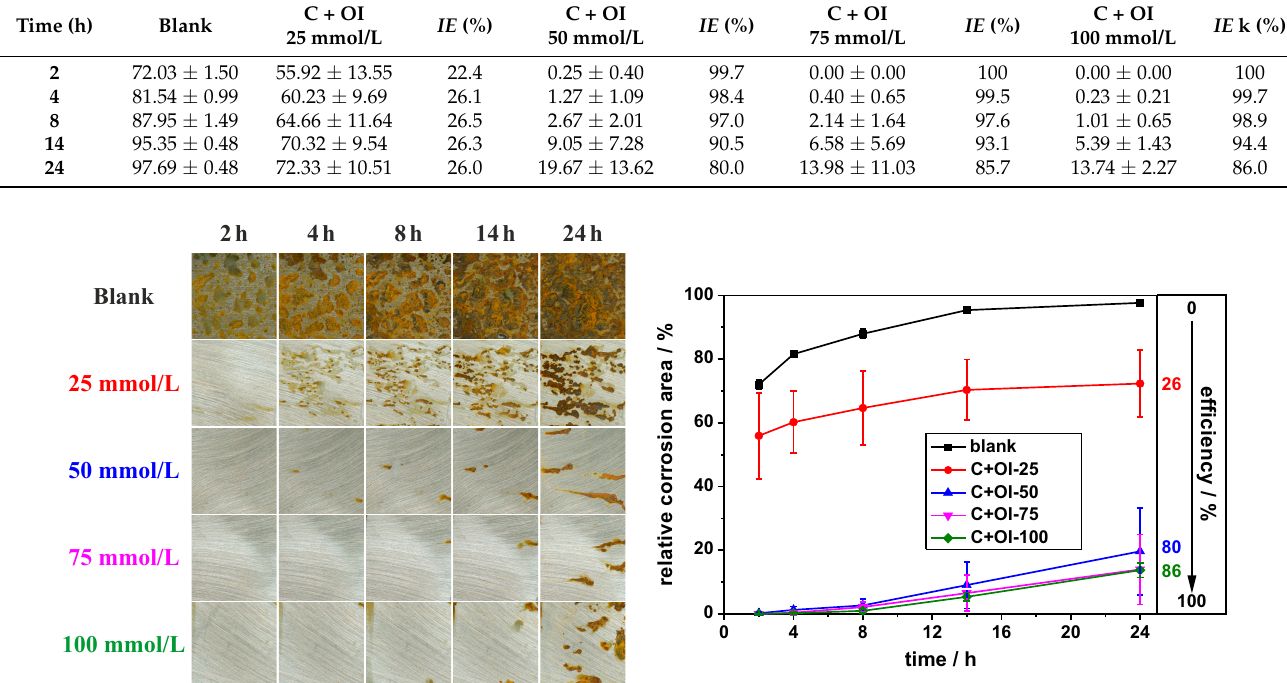
Figure 8. Left : Visible corrosion propagation for blank steel (black) and in the presence of different concentrations of the combination C + OI each at the indicated times. In all cases, only one exemplary run of ten independent specimens with characteristic corrosion patterns is shown. Right : Presentation of the averaged relative corrosion areas during the test period for untreated and treated series with an indication of the IE in % at 24 h (Data points are marked with lines for better